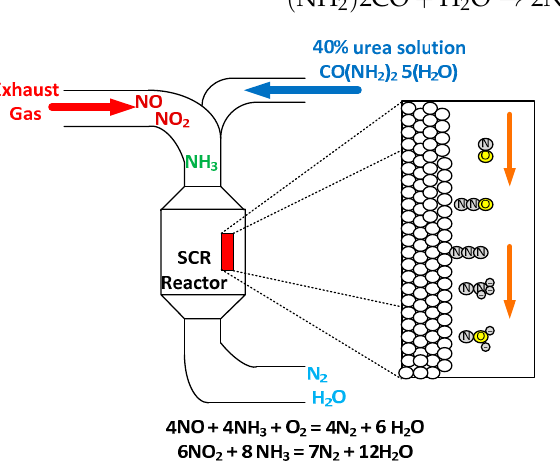
Figure 7. Characteristic view of the operational principle of the selective catalytic reduction (SCR) process. (Figure was genuinely generated using data from refs. [34,35]).